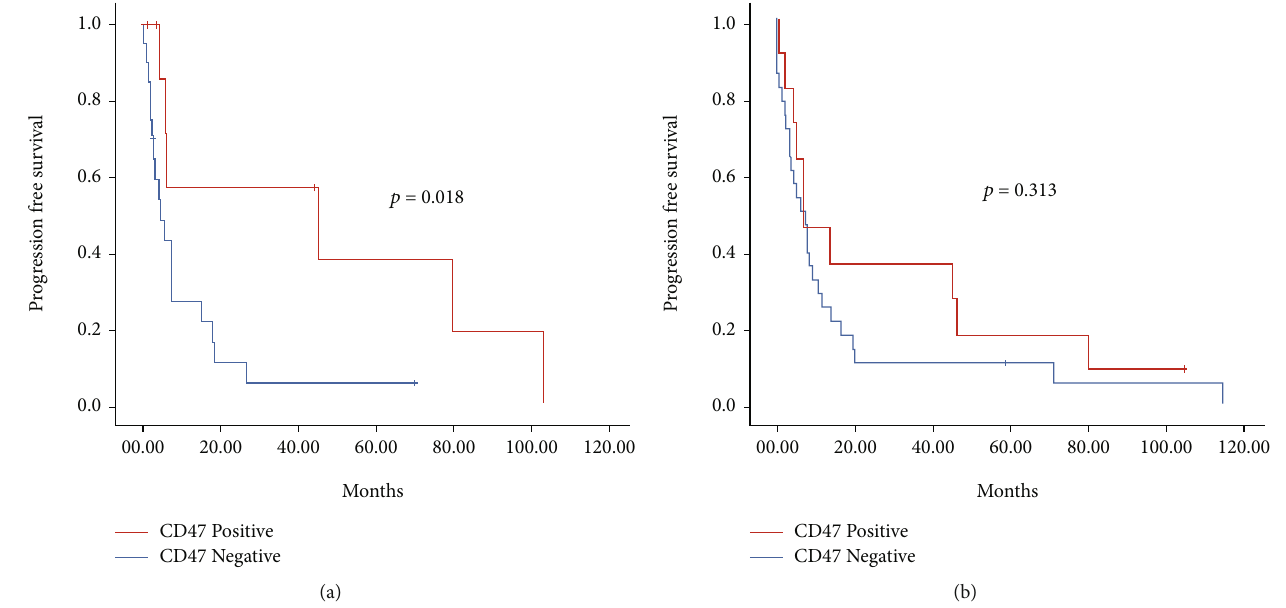
Figure 3: PFS (a) and OS (b) according to CD47 expression in patients with KI ‐ 67 ≥ 40 %